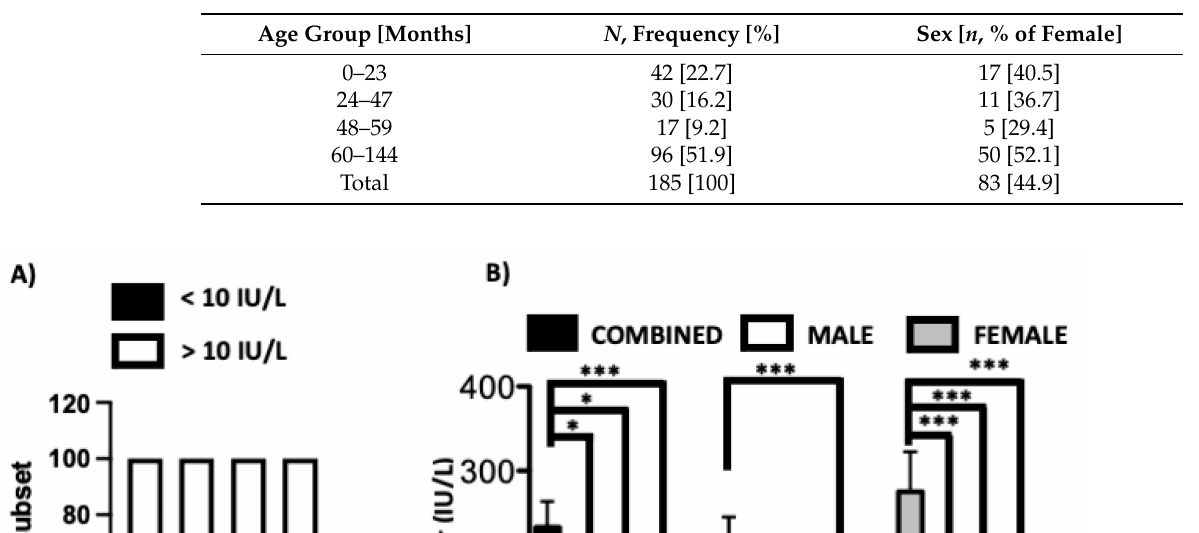
Table 2. Fully vaccinated children cohort. The number of samples as well as the frequency of female participants are indicated for each group.